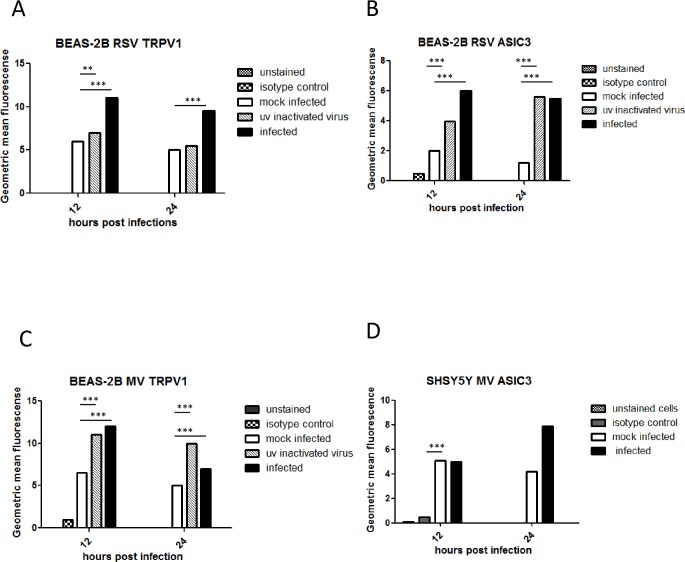
UV Inactivated virus preparations increase TRPV1 and ASICS3 protein expression in BEAS-2B cells.BEAS-2B cells were infected with RSV (MOI 0.1) or MV (MOI 1), or were treated with equivalent virus preparations that had been UV inactivated. TRPV1 and ASIC3 expression was determined by flow cytometry at 12 and 24 hpi. Protein expression levels were quantified by geometric mean fluorescence intensity (GMFI) using Flow cytometry. The results are representative of 3 independent experiments.